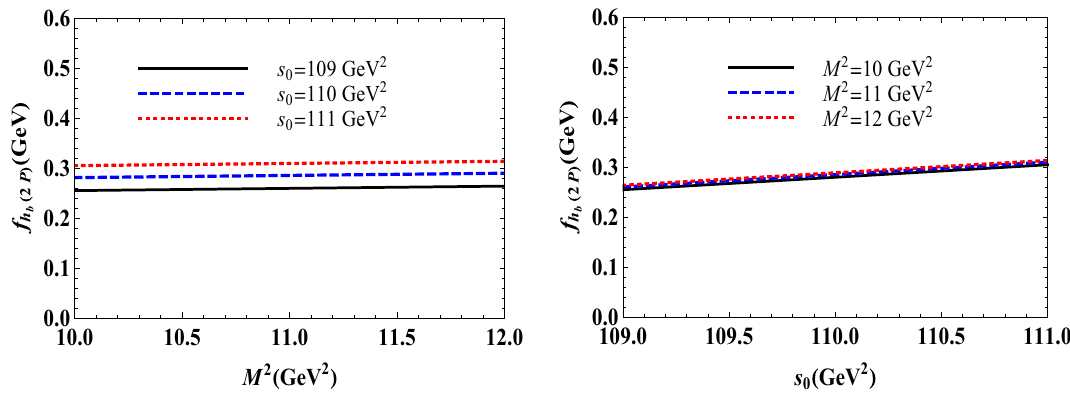
Fig. 4 The dependence of the decay constant f h